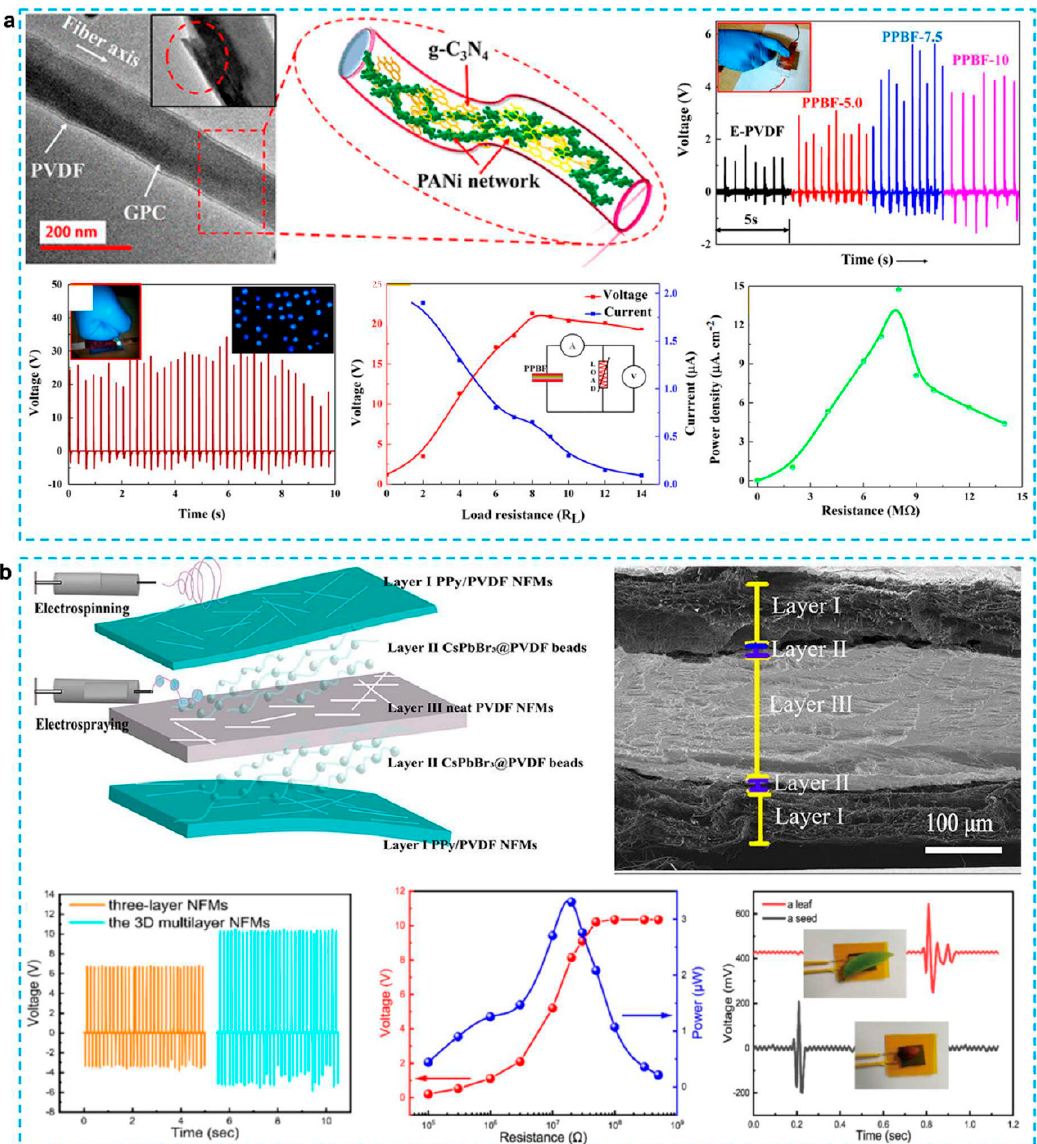
Figure 3. ( a ) Polyaniline-graphitic carbon Nitride nanosheet composite materials with embedded PVDF nanofibers for piezoelectric energy conversion, including TEM morphology, Piezoelectric voltage output for different samples [63]; ( b ) Electrospun/electrosprayed PVDF-based nanofiber and bead multilayer assembly with increased piezoelectricity and high sensitivity, including schematic of the 3D multilayer, cross-section SEM image and generated open-circuit output voltage and short-circuit current [30] .